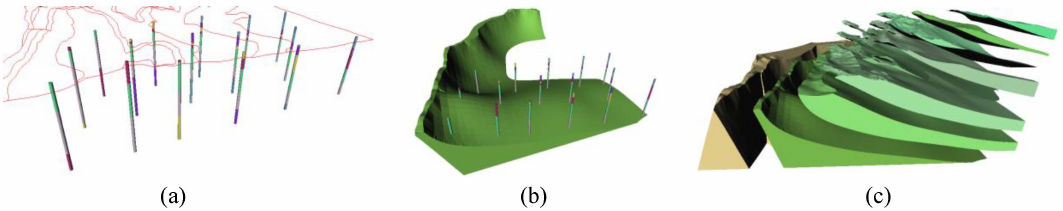
Figure 13. Geological models constrained by Drill-hole data: ( a ) virtual drill-hole data constructed in the area containing stratum; ( b ) the geological model that extended vertically was modified by the drill-holes; and ( c ) the stratum model constrained by the